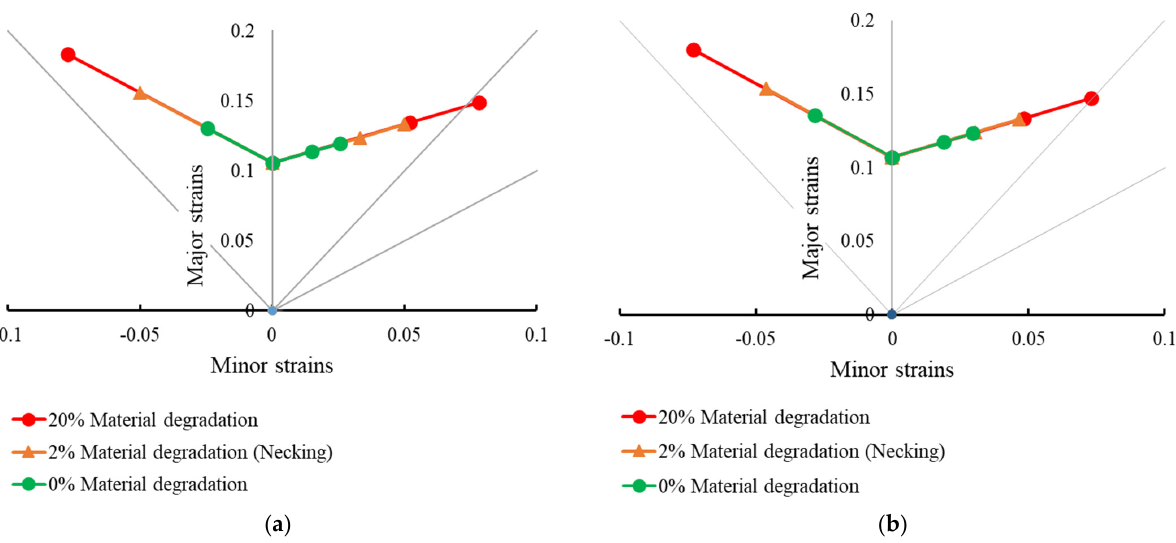
Figure 10. The FLDs marginal zones for ( a ) martensite grain sizes = 2.7 µm and for ( b ) martensite grain sizes = 6 µm.